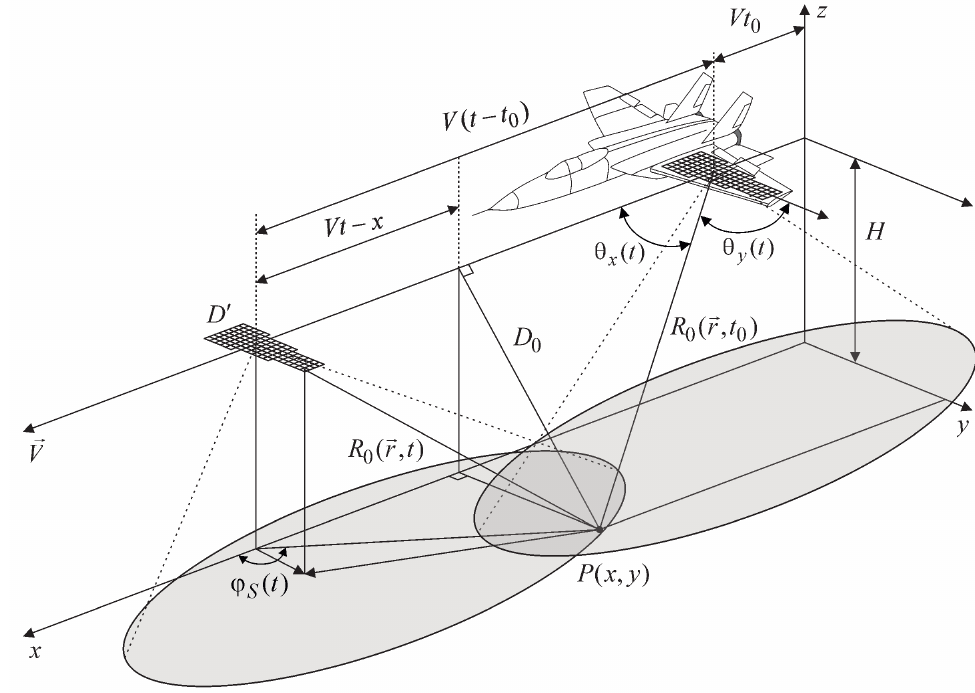
Figure 1. Geometry of surface sensing.